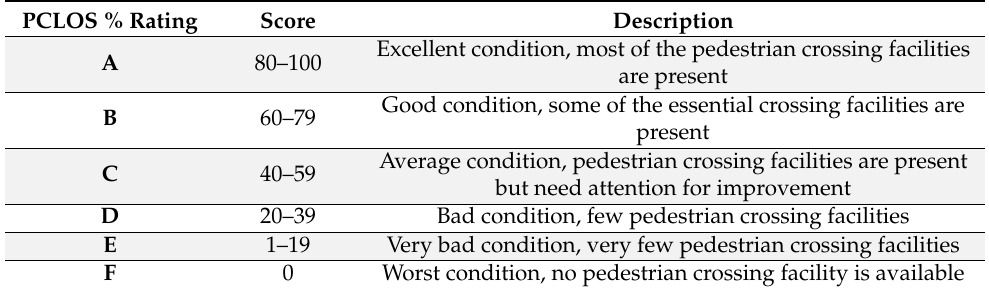
Table 4. Description of the pedestrian crossing level of service rating and